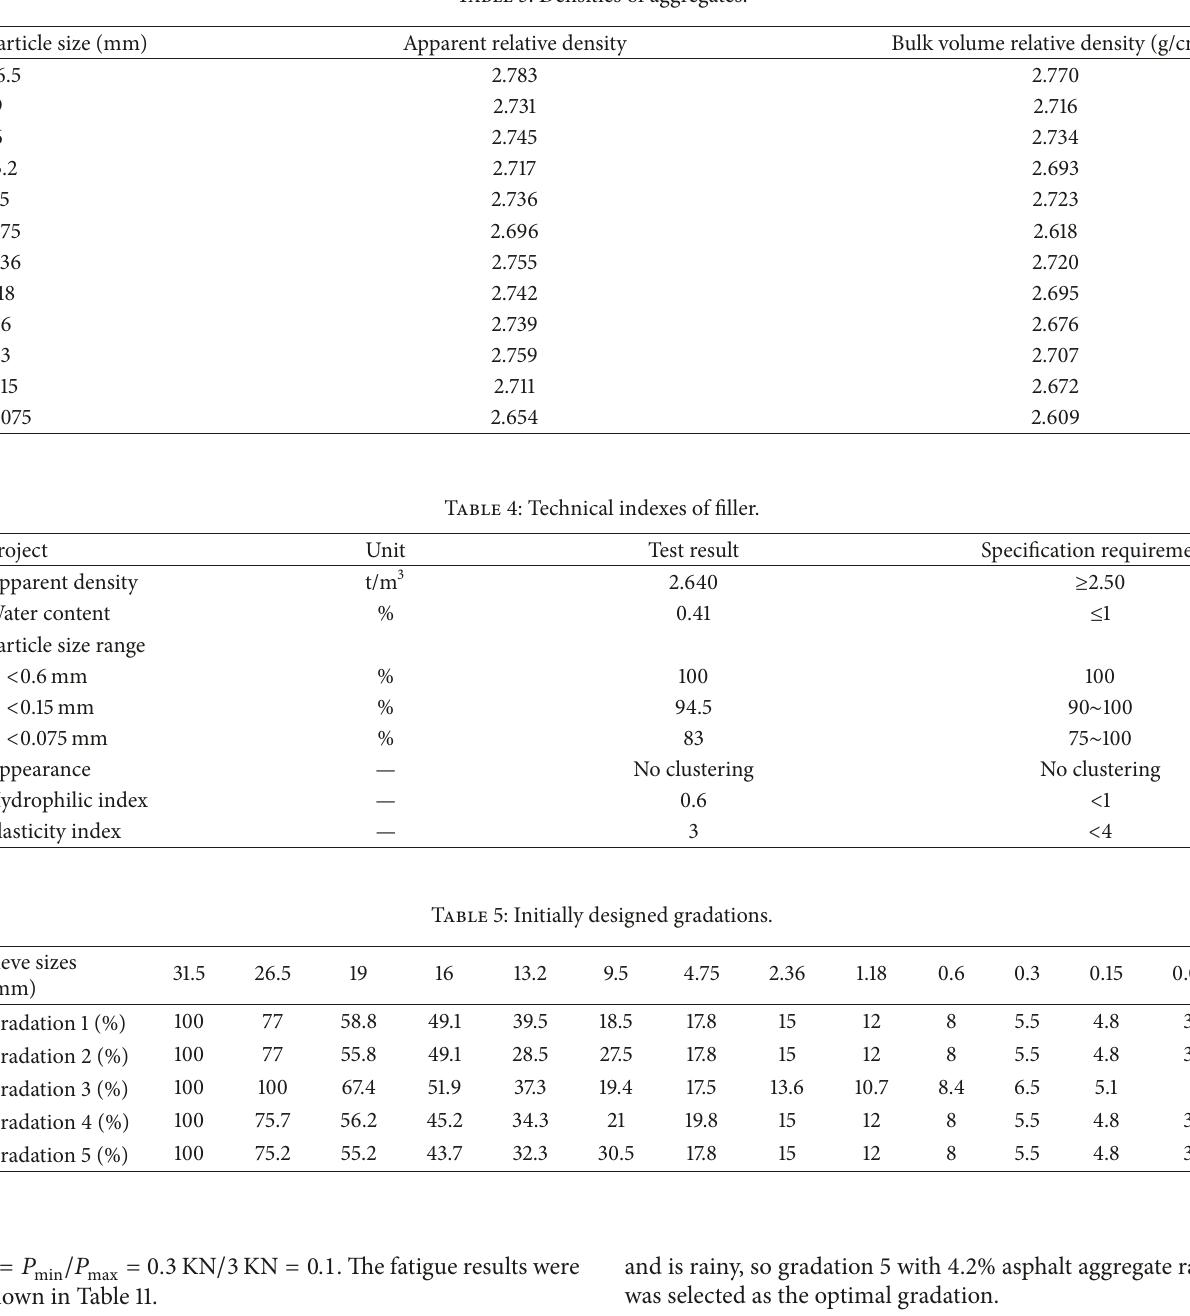
Table 3: Densities of aggregates.